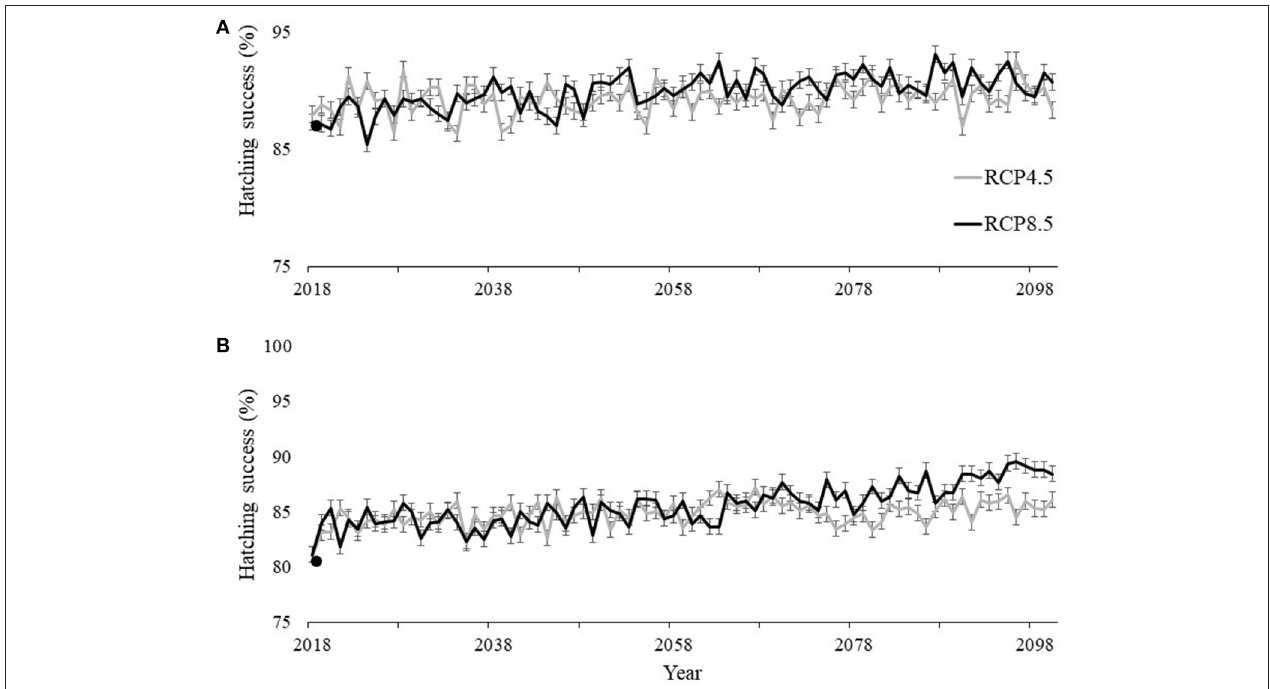
FIGURE 7 | Historic average (solid points) and projected hatching success at (A) T.H. Stone Memorial St. Joseph Peninsula (SJP) and (B) St. George Island (SGI) under the extreme (black line) RCP8.5 scenario where greenhouse gas concentrations continuously increase and the more conservative (gray line) RCP4.5 scenario where greenhouse gas concentrations stabilize. Bars indicate 95% confidence intervals for each projected hatching success value up to 2100.